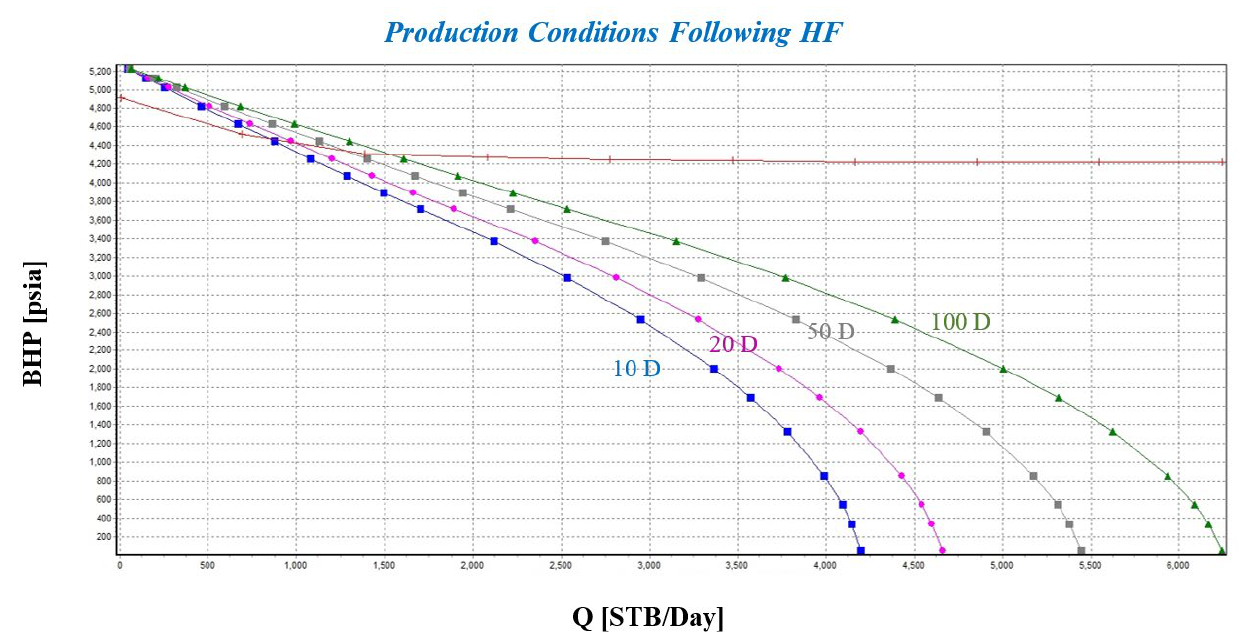
Figure 14. Production parameters after hydraulic fracturing with sensitivity analysis on the fracture permeability ranging from 10 D (blue-color curve) to 100 D (green-color curve). Table 4. Sensitivity analysis of fracture permeability on production conditions.